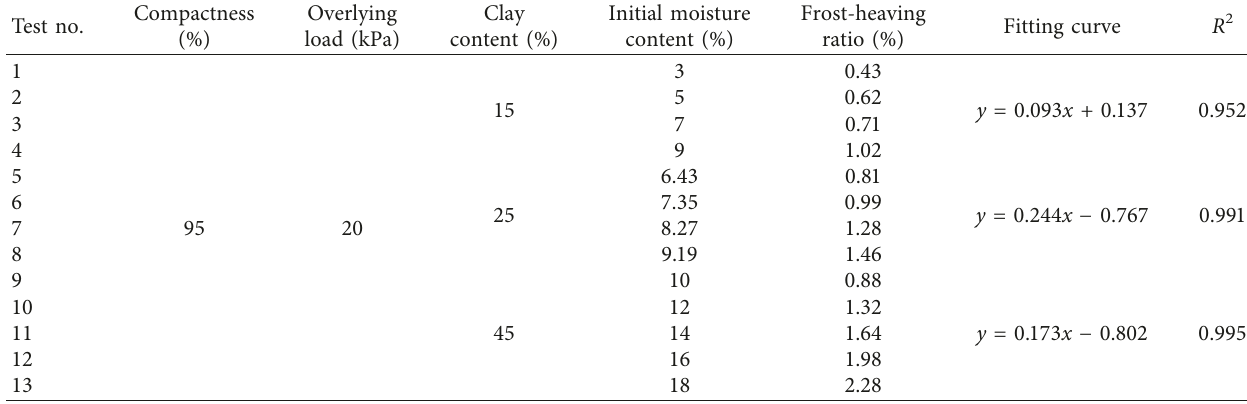
Table 2: Influence of various initial moisture contents on frost-heaving ratio.